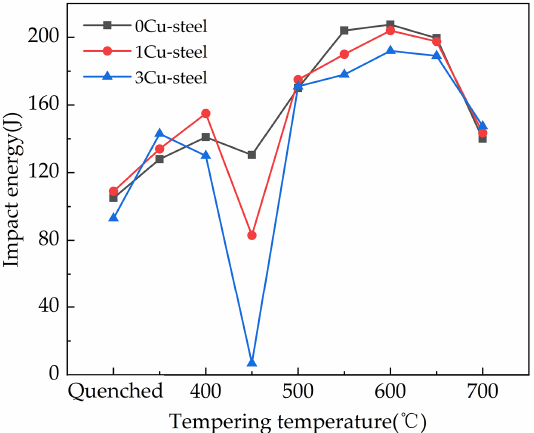
Figure 3. Quenching and tempering temperature dependence for the Charpy impact energy of the 0Cr13Ni4Mo steels with different Cu content.